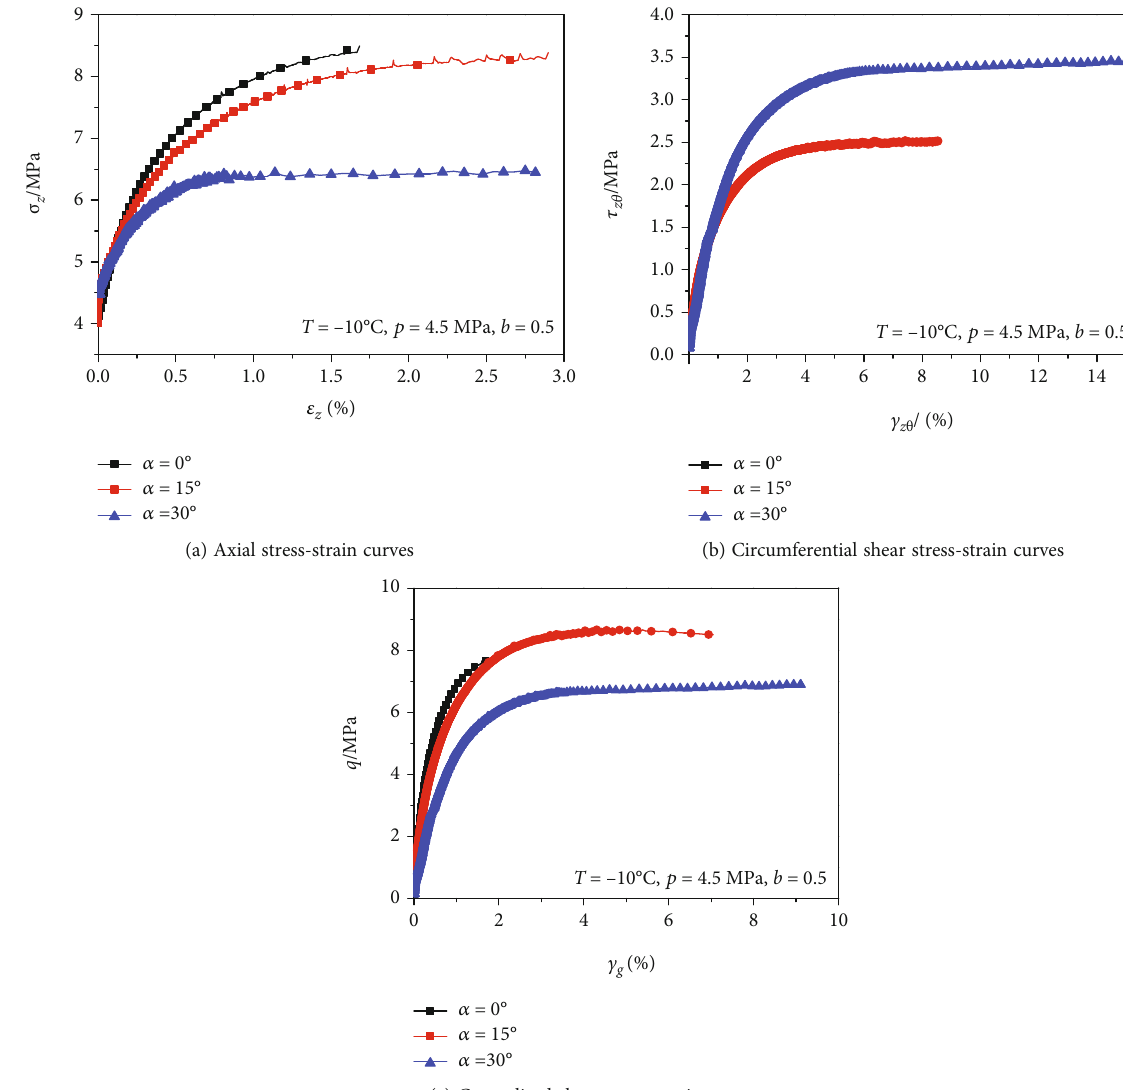
Figure 12: Stress-strain curves of the FSS under di ff erent principal stress